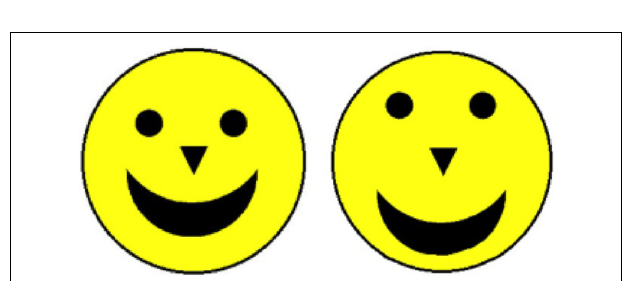
FIGURE 2 | An example of a test trial in the Configural condition. The stimulus on the right is an example of a configurally-changed face, while the stimulus on the left is the familiarized